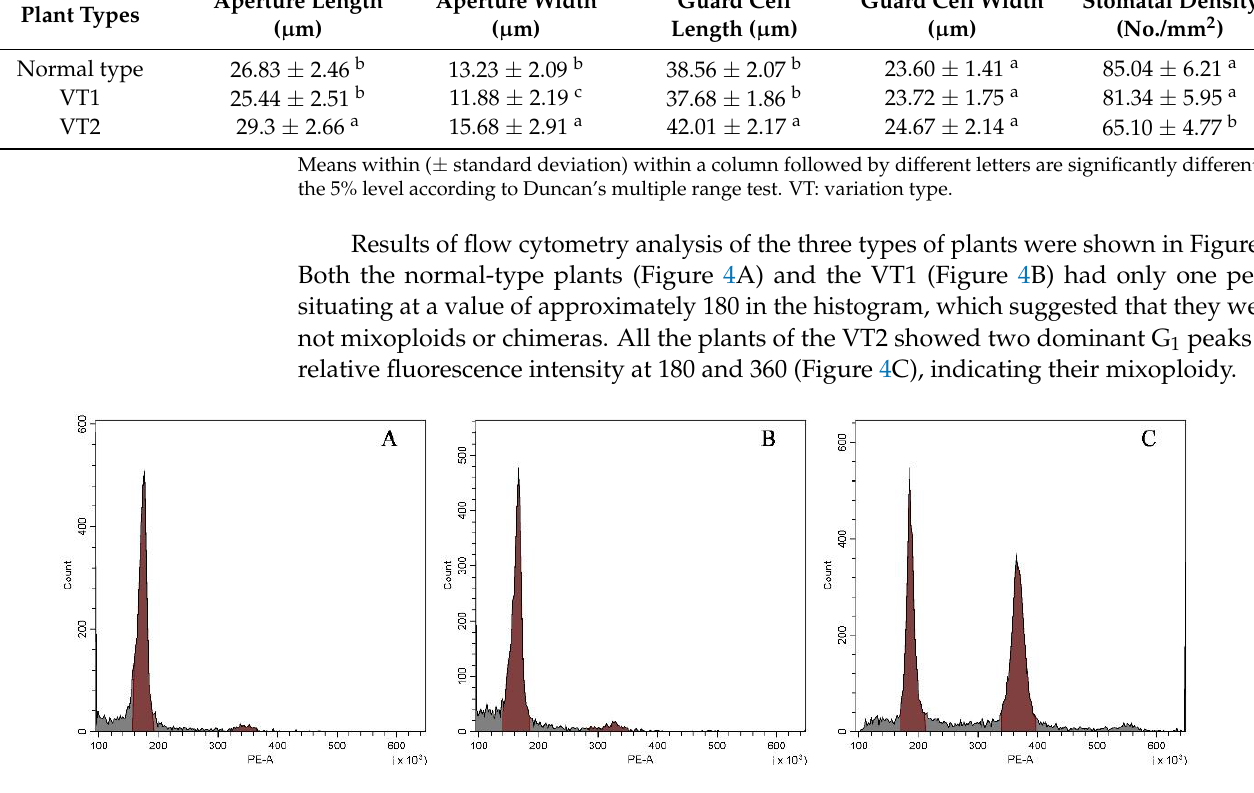
Figure 4. Histograms of relative 2C DNA content in the nuclei isolated from the normal-type ginger ( A ) and the two morphological variation types, namely the VT1 ( B ) and the VT2 ( C ). To confirm the results of flow cytometry analysis, chromosome number counting